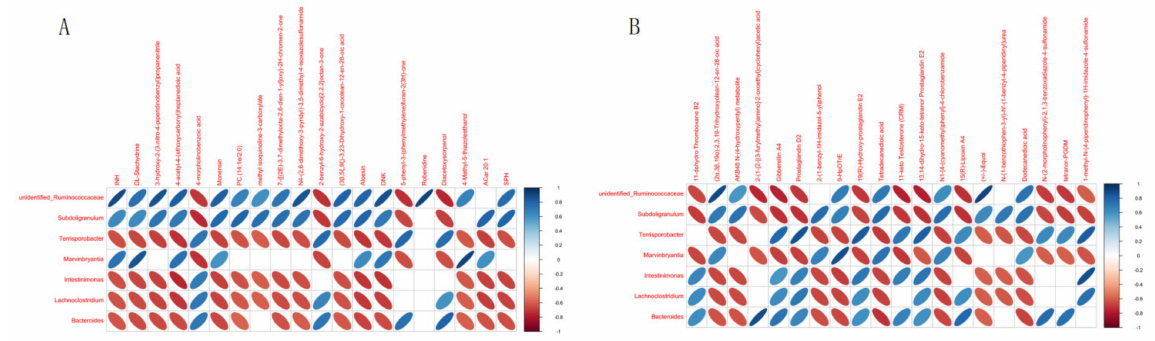
Figure 11. Correlation analysis results of differential-metabolites top20 and 16S microbial-genomic Top10. Positive DMs ( A ), negative DMs ( B